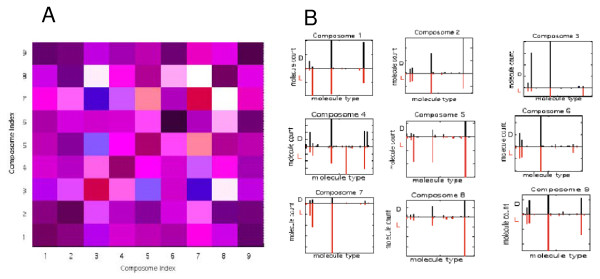
A, the chiral relations among the composomes of Figure 9, with color scheme as in Figure 7; B, the compositional bar charts for all 9 composomes.